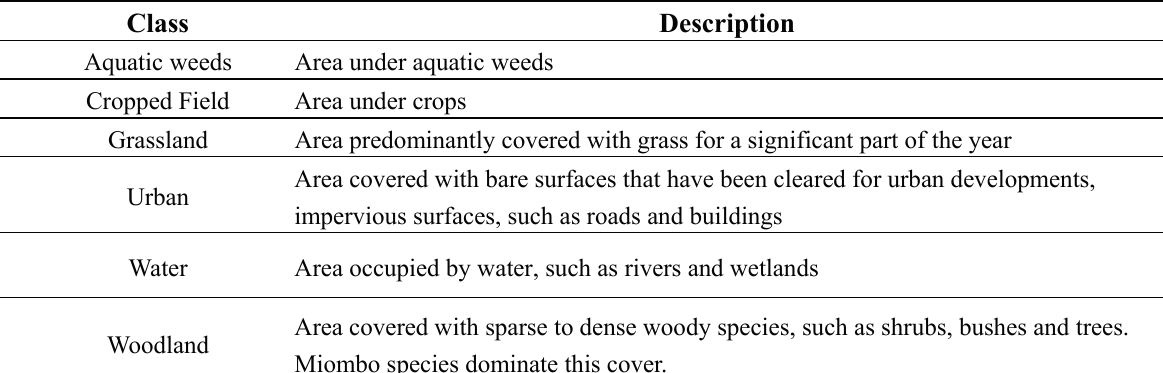
Table 3. Description of the land cover classes used in the